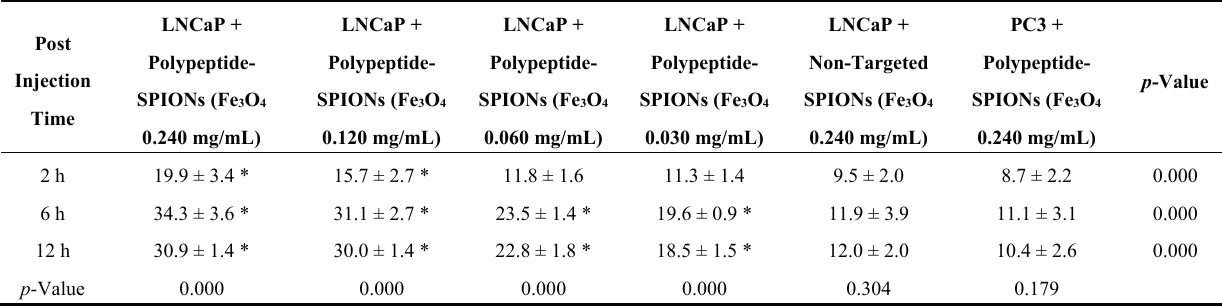
Table 1. RSE data in LNCaP tumor bearing mice injected with polypeptide-SPIONs, non-targeted SPIONs, and PC3 tumor bearing mice injected with polypeptide-SPIONs. Post